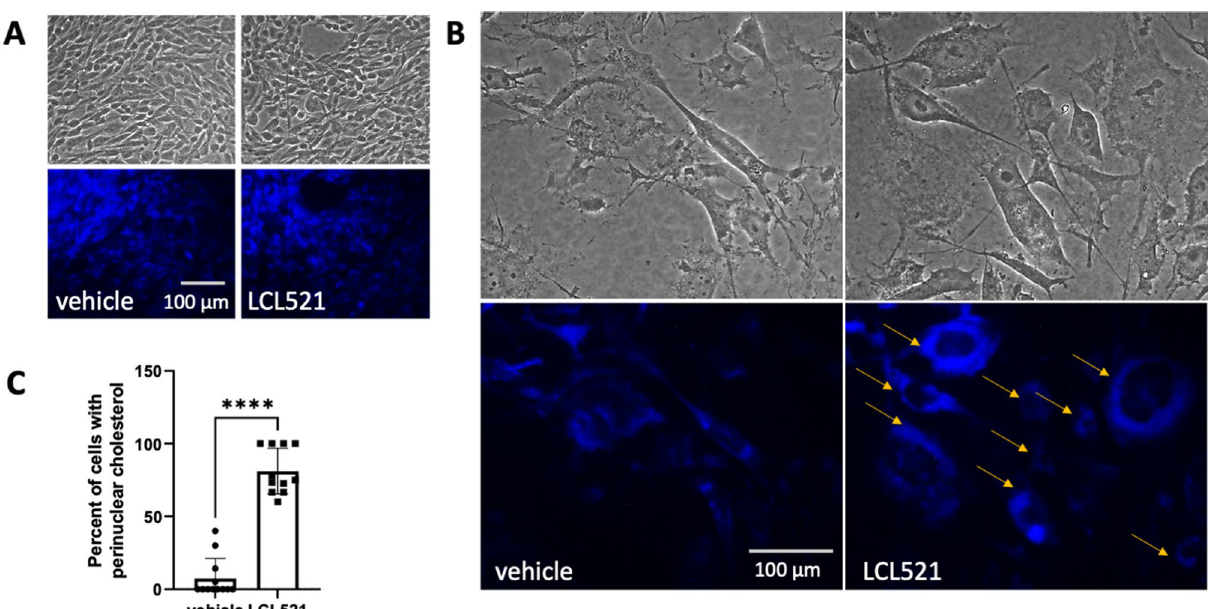
Figure 5. Cholesterol staining changes in PGCC upon LCL521 treatment. ( A ) Uncropped 20X images of parental cells stained with filipin III to visualize cholesterol after 48 h of indicated treatment. ( B ) 20X images of PGCC after the same protocol as ( A ). Yellow arrows indicate the perinuclear accumulation of cholesterol. ( C ) Quantification of at least three images per experiment over three experiments; vehicle treated PGCC n = 86 and LCL521 treated PGCC n = 73. **** p <